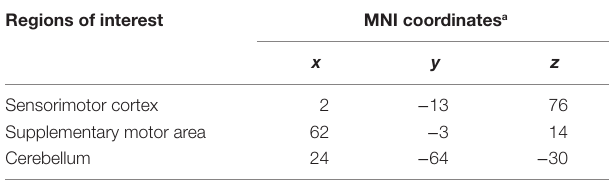
TaBle 2 | list of regions of interest based on Onozuka et al. (2003) Table 1, the aged subjects . regions of interest